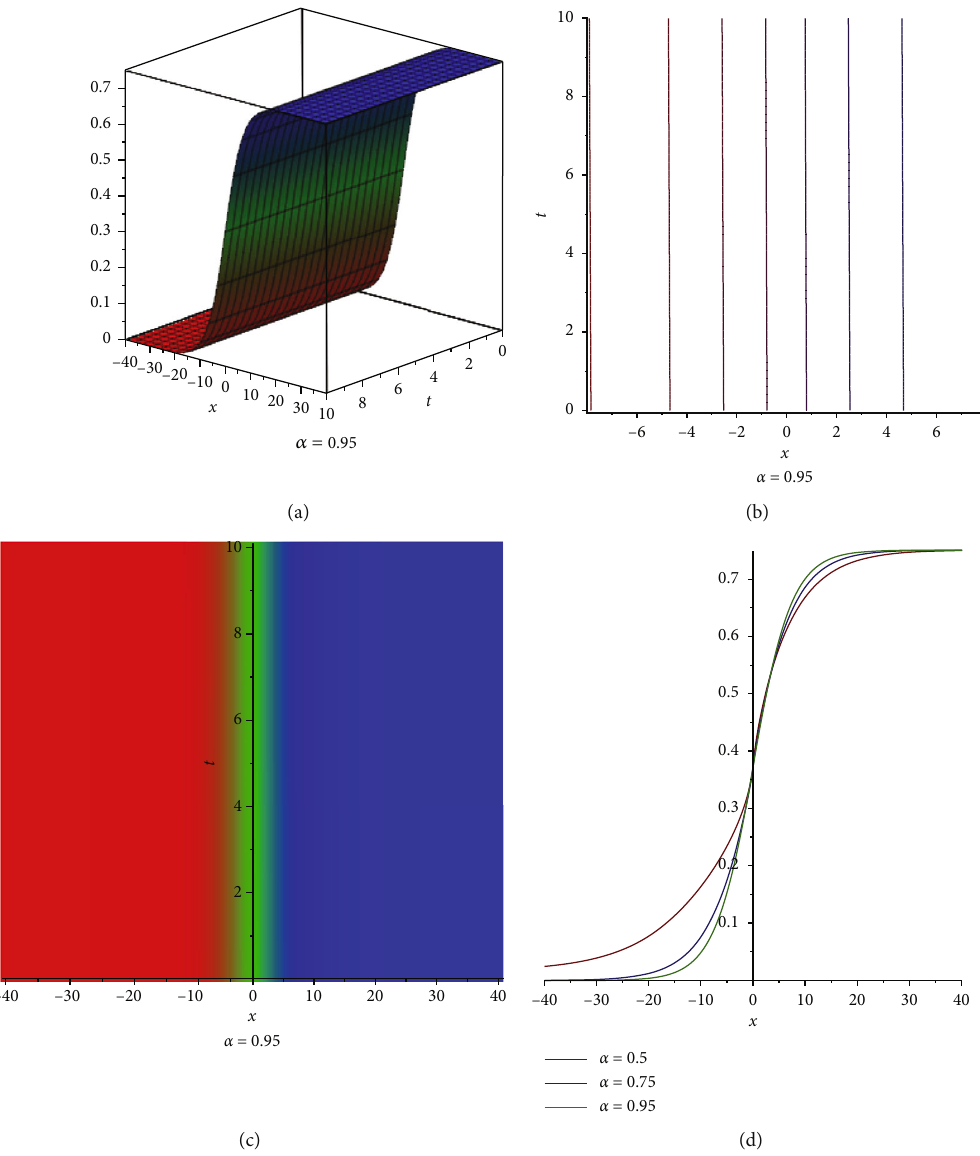
= 0 : 3, δ = δ = d = d = 0 : 1, 1 2 3 1 2